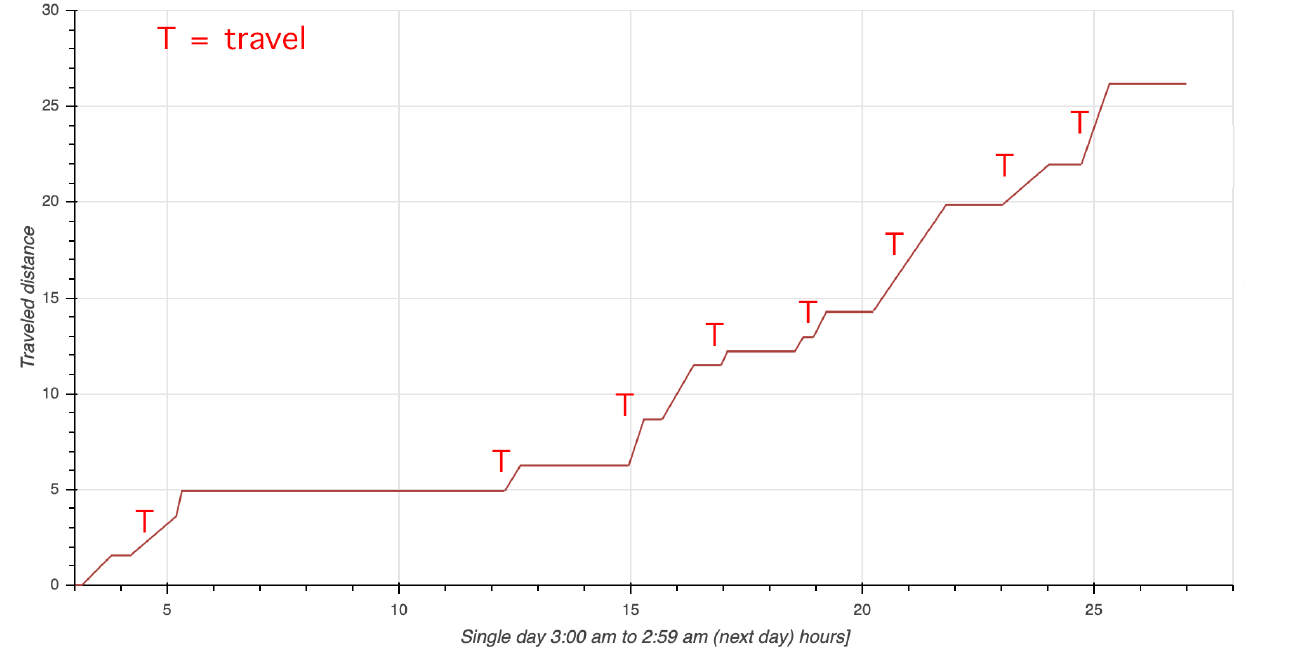
Figure 9. Traces and travels for a random